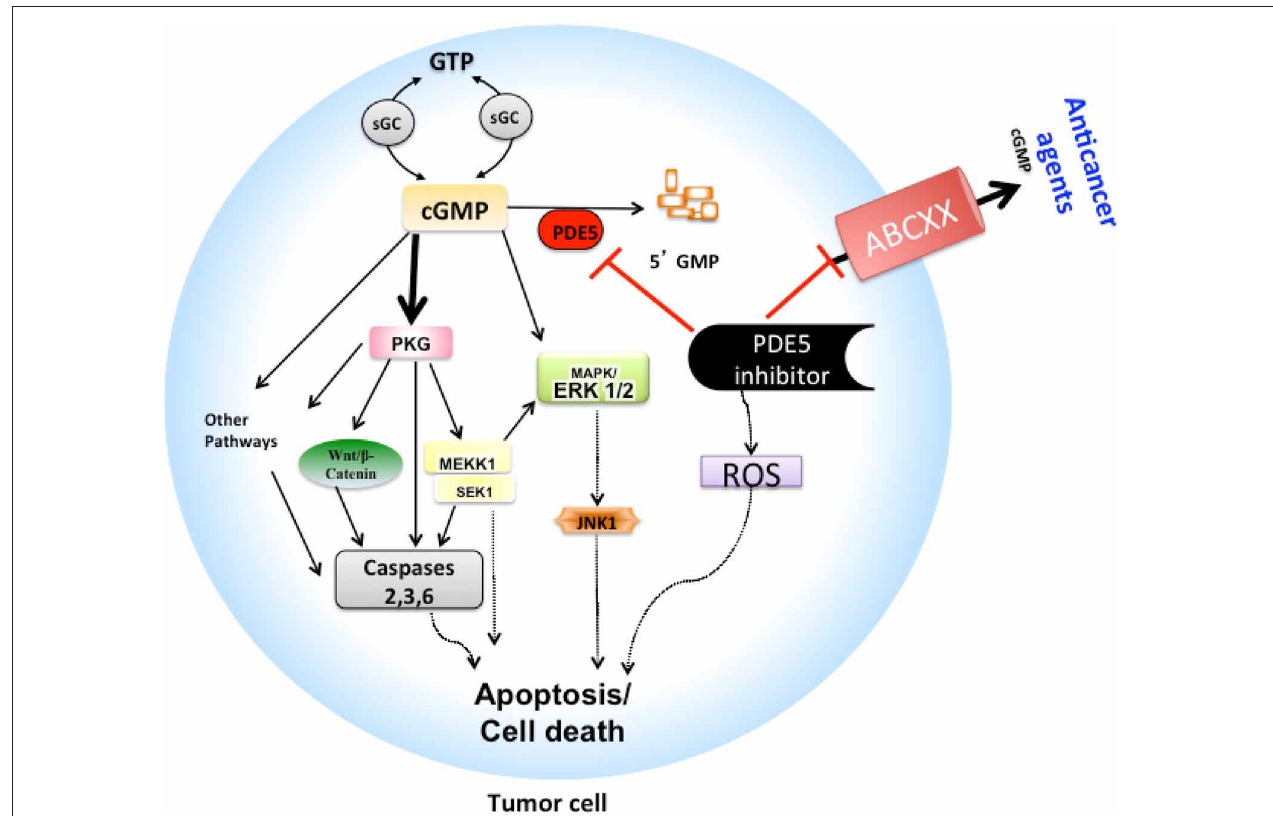
FIGURE 1 | Schematic model of PDE5 inhibitors mechanism as chemoadjuvants: Proposed model is shown (A) as how tumor cells can efflux cGMP and variety of anticancer drugs that are substrate of ABCB1, ABCG2, ABCC4, ABCC5, and ABCC10 and so survive in the absence of PDE5 inhibitors. (B) Probable mechanism by which the PDE5 inhibitors such as sildenafil, vardenafil and tadalafil produces apoptotic activity is shown, which may be due to (1) inhibition of PDE5 activity, thus increasing cGMP-PKG activation, which leads to activation of series of signaling events including phosphorylation of β -catenin and/or